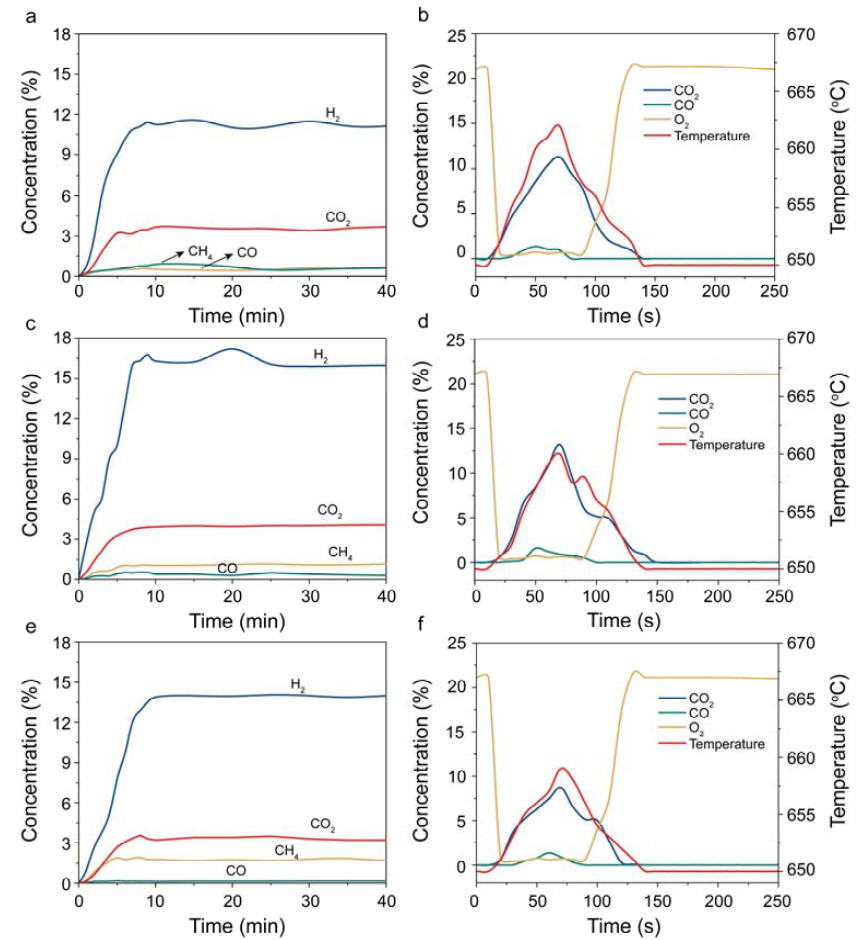
Figure 5. Activity tests in fuel feed step and air feed step. ( a ) and ( b ) La 1.4 Sr 0.6 Ni 0.2 Co 0.8 O 4 ; ( c ) and ( d ) La 1.4 Sr 0.6 Ni 0.6 Co 0.4 O 4 ; ( e ) and ( f ) La 1.4 Sr 0.6 NiO 4 . ( c , d ) La 1.4 Sr 0.6 Ni 0.6 Co 0.4 O 4 ; ( e , f ) La 1.4 Sr 0.6 NiO 4